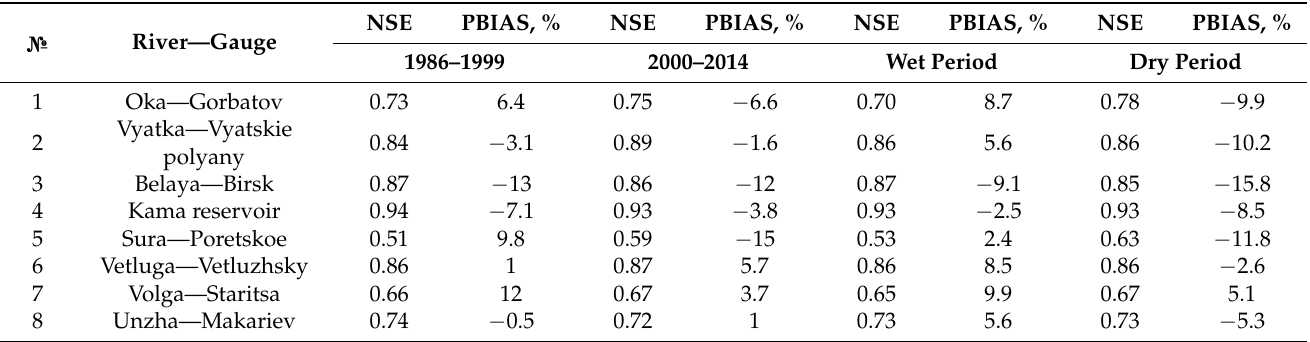
Table 3. Model performance of daily runoff in the Volga River basin for the period of model calibration and